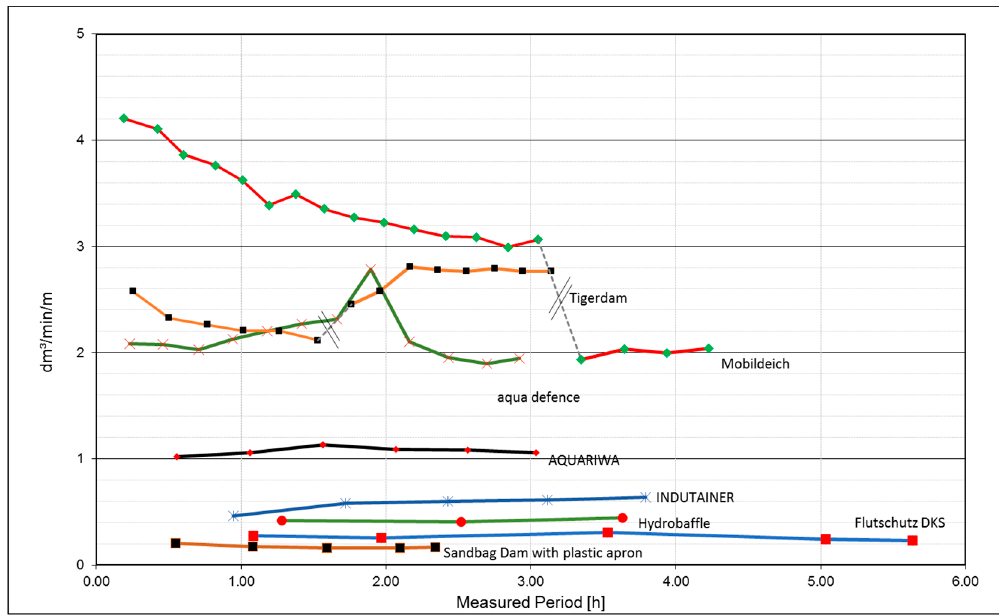
Figure 15. Selection of seepage rates of individual mobile systems with a water head of 0.6 m.